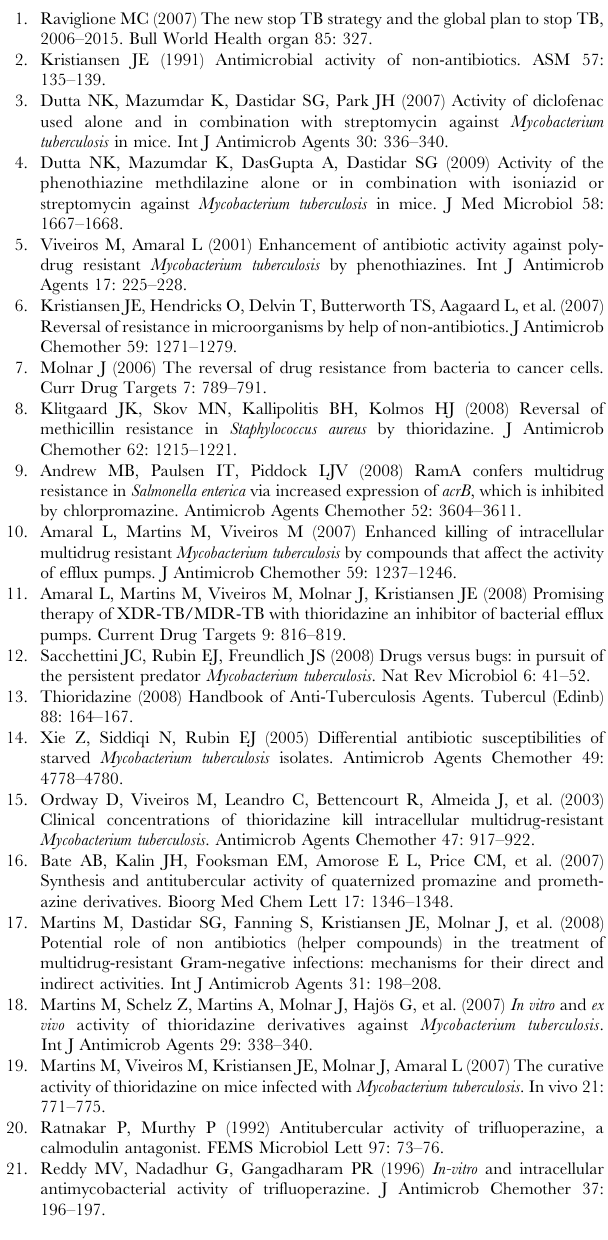
base 2 logarithmic scale. The intensity of red color correlates with a higher degree of expression in Mtb treated with THZ relative to the control Mtb strain, while the intensity of the blue color correlates with a lower degree of expression in Mtb treated with THZ relative to the control Mtb strain. The genes with the highest degree of blue and red color corresponds to a log2 fold change value of 5.81 (i.e. a numeric fold change of . 56 fold).